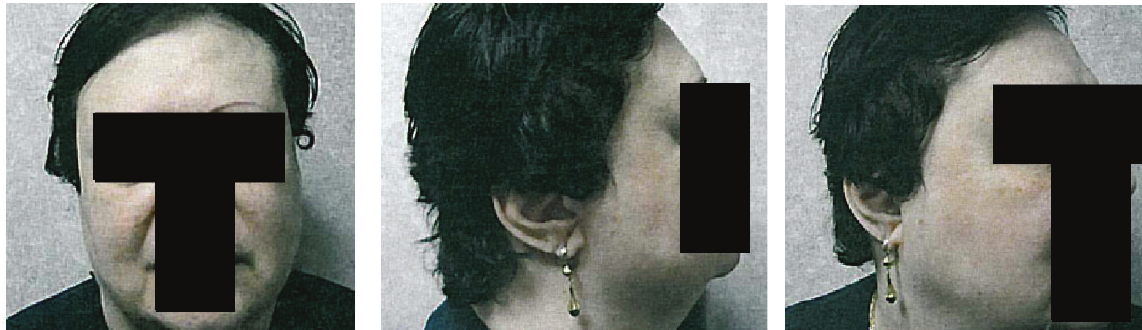
Figure 5: Follow-up of patient at 4 years demonstrating excellent